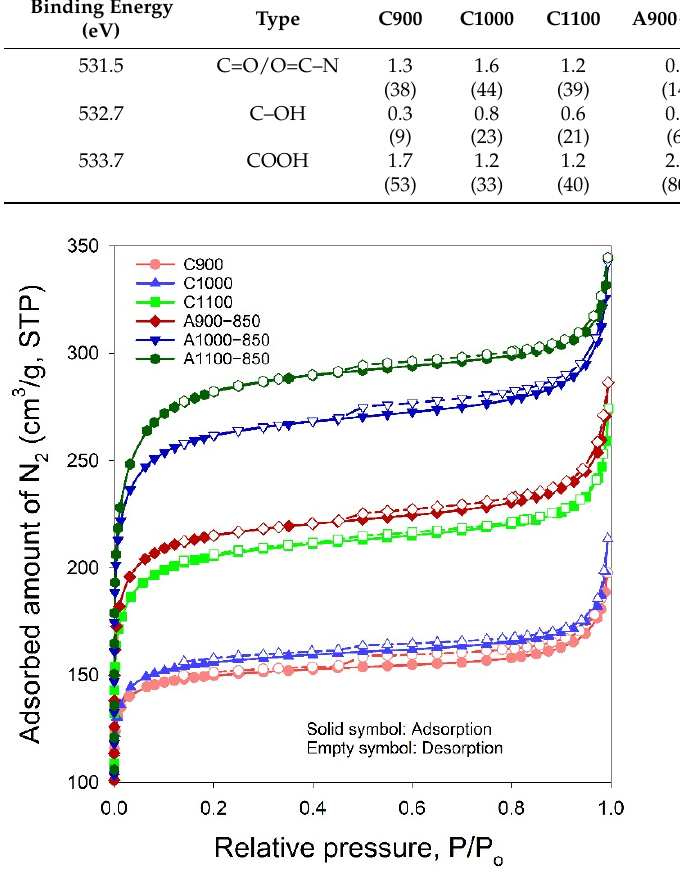
Figure 6. N 2 adsorption–desorption isotherms at − 196 °C for all